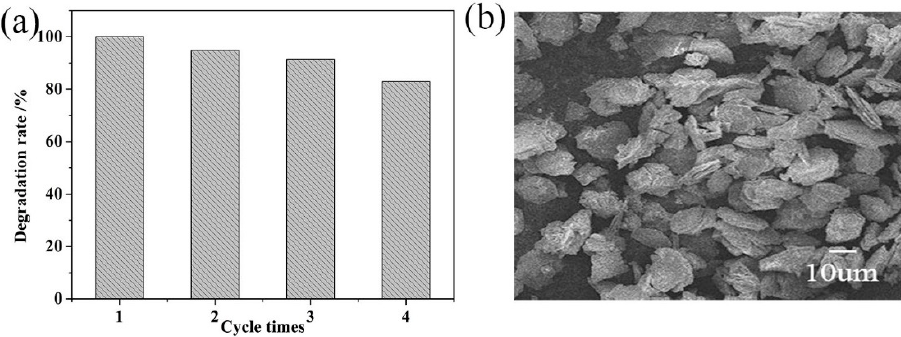
Figure 7. ( a ) Degradation efficiency of MB for KFO-20 at different cycles; ( b ) SEM image for KFO-20 after four successive cycles.